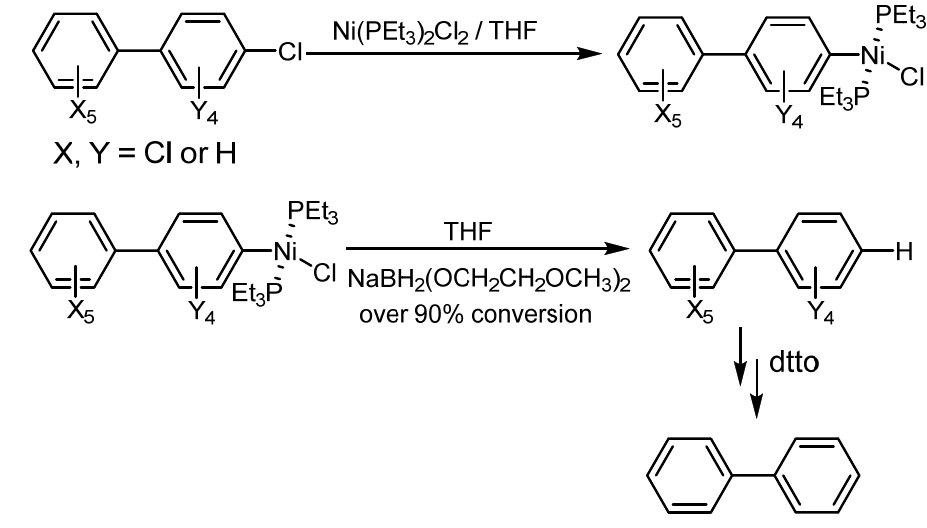
Scheme 9. HDH of Ar–X using Ni(PPh 3 ) 2 Cl 2 with 2 equivalents of PPh 3 in ethanol/pyridine with subsequent addition of excess NaBH 4 (benzene was produced with 100% conversion using 2 mmol 1,2,3-TCB dissolved in 10 mL ethanol/pyridine 9/1 with addition of 0.05 mmol Ni(PPh 3 ) 2 Cl 2 , 0.1 mmol PPh 3 and 7 mmol NaBH 4 at 70 °C/3 h) [60]. Recently, a series of Ni(NNP) pincer complexes with HDH activity in co-action of excess of NaBH 4 as a reductant was described by Wang and Gardinier [61]. This system (especially in case if R = methoxy or methyl) was recognized as effective mainly for hy- drodebromination of Ar–Brs and hydrodeiodination of Ar–Is but is very slow in case of HDC of Ar–Cls in N,N-dimethylacetamide (DMA) even at 80 °C [61] (Scheme 10).